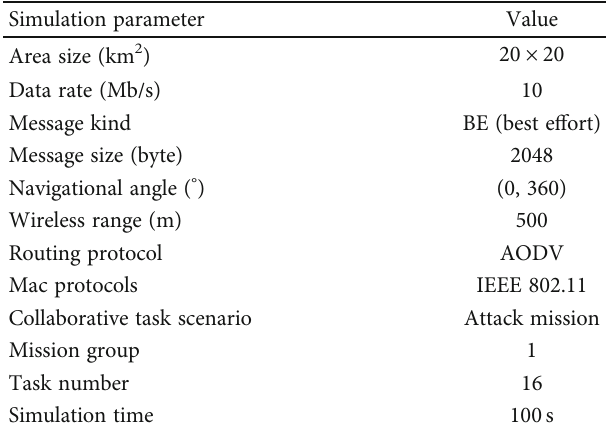
Table 4: Scenario simulation